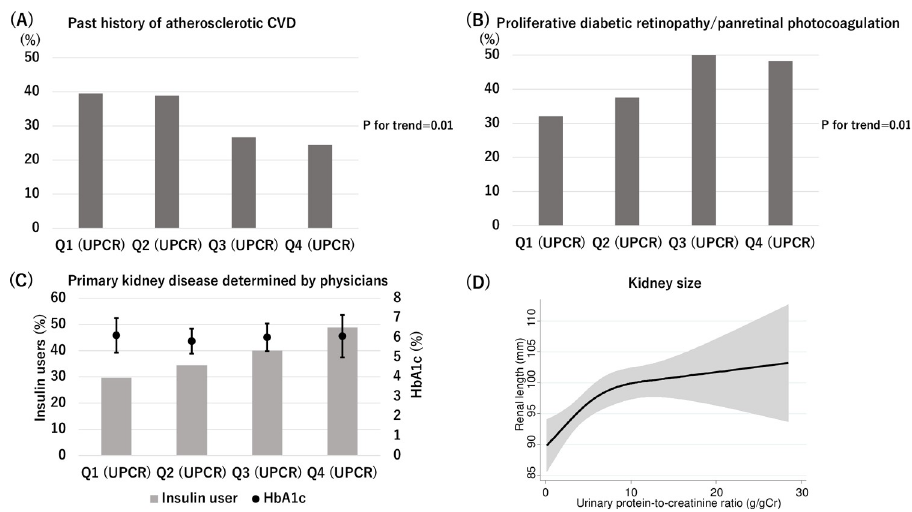
Fig 2. Baseline characteristics across the quartiles of UPCR. (A) Patients with lower quartile of UPCR are more likely to have a history of atherosclerotic CVD. (B) Patients with greater quartile of UPCR are more likely to have advanced diabetic retinopathy (proliferative diabetic retinopathy or history of panretinal photocoagulation). (C) Patients with greater quartile of proteinuria tend to receive insulin at dialysis initiation (P for trend = 0.01). There are no significant differences in HbA1c levels across UPCR quartiles. (D) Patients with low levels of proteinuria have small renal length. The association is adjusted for age, sex, eGFR, height, body mass index at discharge, and modality for measurement of renal length (CT or ultrasonography). Abbreviations: CVD, cardiovascular disease; eGFR, estimated glomerular filtration rate; HbA1c, glycated hemoglobin